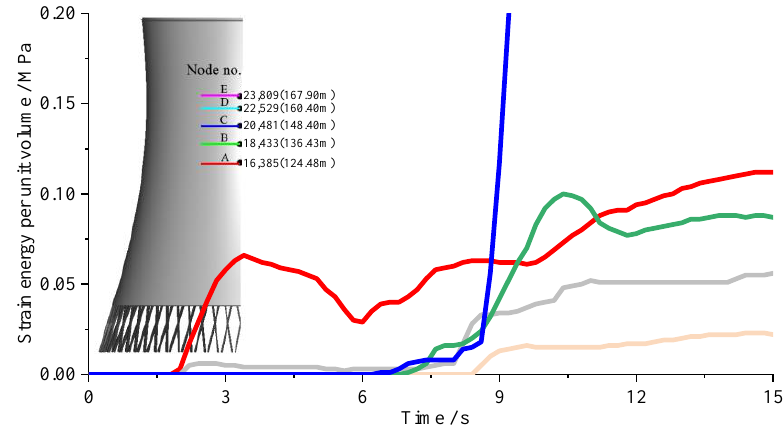
Figure 21. Time history of strain energy per unit volume.